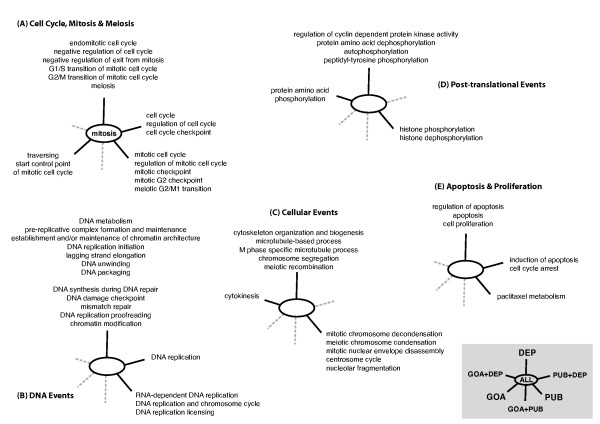
Venn categories for the functional annotation of the cdc2 gene (Process hierarchy). Annotations: GOA (Evidence), PUB (Literature), DEP (Associative relations) and overlaps between them (GOA+PUB, GOA+DEP, PUB+DEP, ALL = GOA+PUB+DEP).